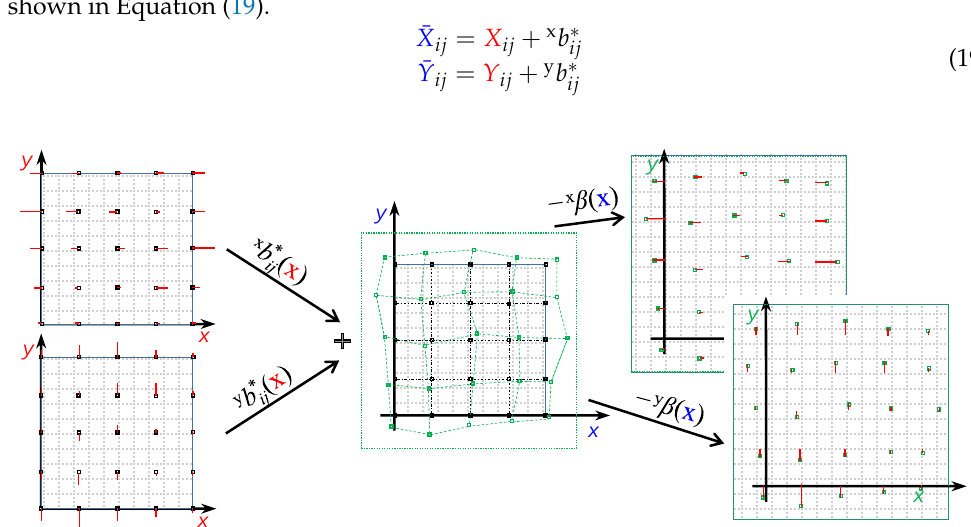
Figure 9. Diagram of derivation of debiasing functions in x direction x β ( x ) and y direction y β ( x ) .